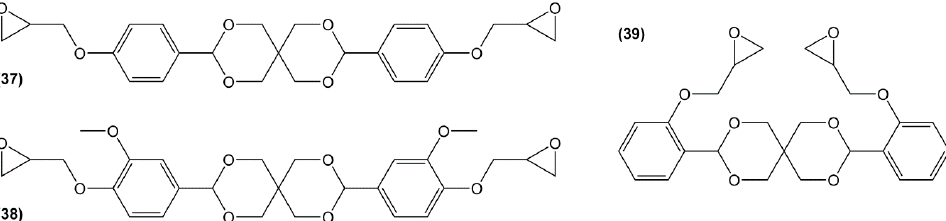
Figure 24. Diglycidyl ether derivatives containing spiro rings.